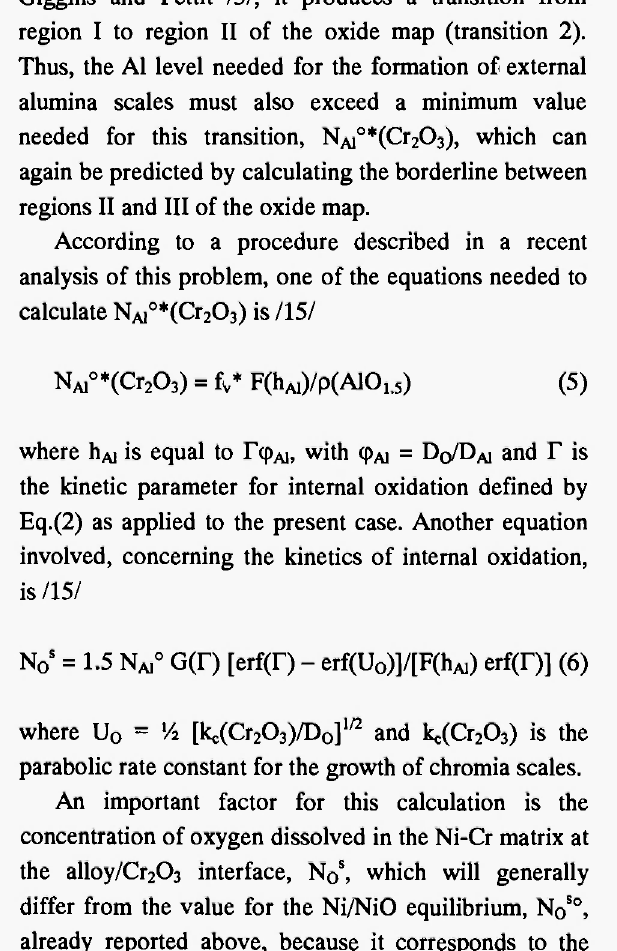
Fig. 3. In the range of composition considered NAi°*(Cr 2 0 3 ) is practically constant and equal to about 1.7 % Al. In Fig. 3 curve b is actually interrupted at its crossing point with curve a, corresponding to N Cr °* s 7.1 %, because in region I curve b is only virtual. The value of NAi°*(Cr 2 0 3 ) calculated above (1.7 %) is much smaller than that calculated above for binary Ni-Al alloys (11.63%): this is a consequence of both the low values of N 0S prevailing under external chromia scales as compared to N 0So and of the lower value of k c (Cr 2 0 3 ) as compared to k^NiO). In fact, if N A] °*(Cr 2 0 3 ) is calculated using the correct value of kc(Cr 2 0 3 ), but point of crossing with curve a becomes equal to about 8.3%. Conversely, if N A1 °*(Cr 2 0 3 ) is calculated using the correct N 05 beneath chromia scales, but setting 1^(0· 2 0 3 ) = kc(NiO) it becomes equal to about 5.1%. In any case, according to the previous calculation, to produce external alumina scales on ternary Ni-Cr-Al alloys at 1173K the mole fraction of Al must exceed about 1.7 %.